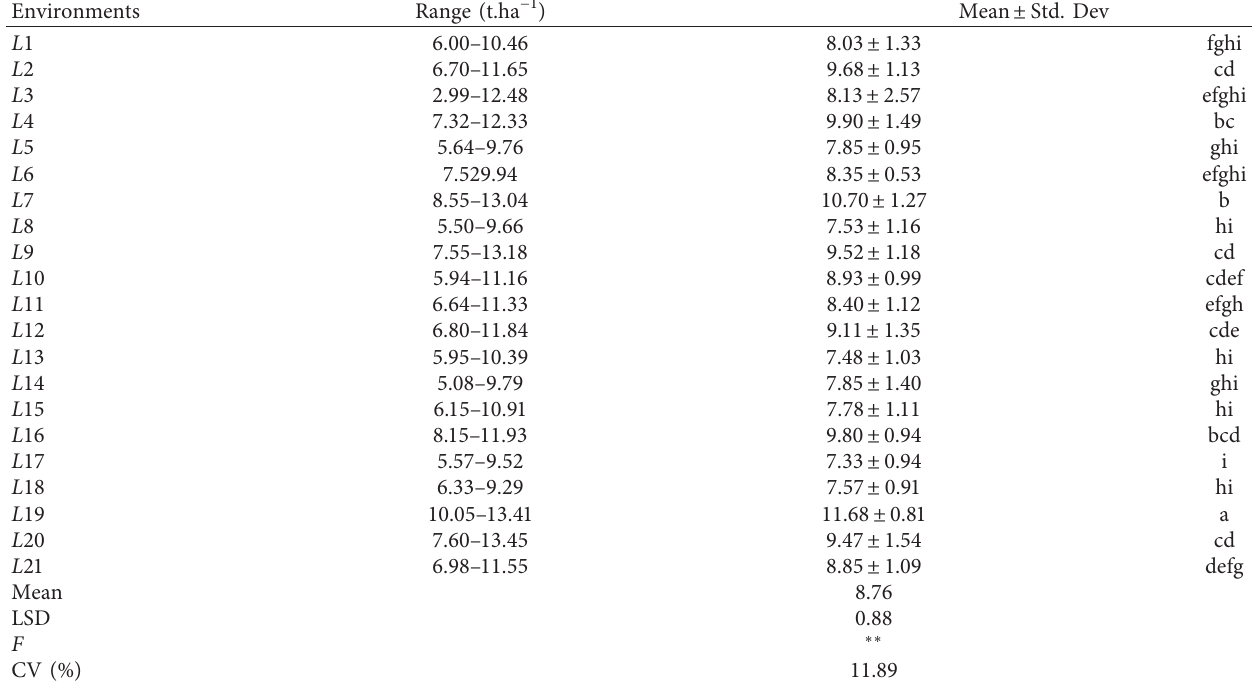
Table 4: Combined analysis of variance for grain yield data of twenty-one environment